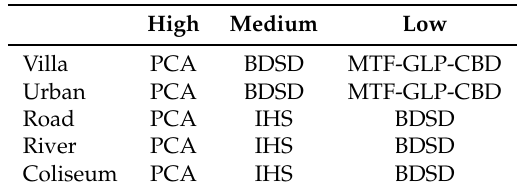
Table 17. Clustering of pan-sharpening algorithms applied to IKONOS Roma Villa, Urban, Road, River, and Coliseum scenes’ data into high, medium, and low performance. Input data for clustering are the DMOS GM = DMOS TC DMOS PS IQA-based indexes Q S , Q C , Q D , Q NIQE , and Q OA in Tables 9–13.